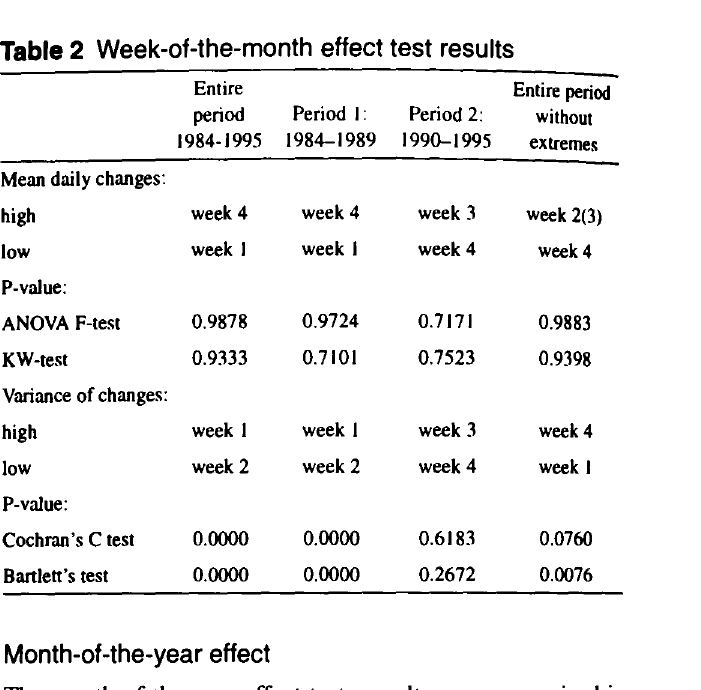
Table 2 Week-of-the-month effect test